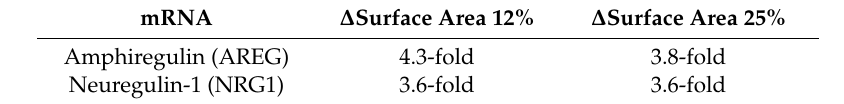
Table 1. Human epidermal growth factor receptor (HER) ligands upregulated with 6 h of cyclic stretch of rat alveolar epithelial cells.